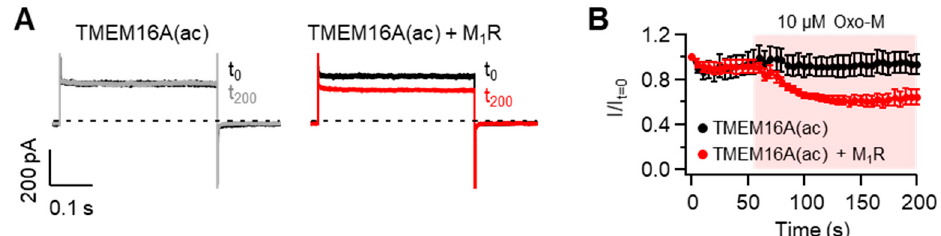
Figure 6. Modulation of TMEM16A(ac) channels by the M 1 muscarinic receptor (M 1 R). ( A ) Representative Cl − current traces of TMEM16A(ac) before and after application of the M 1 R agonist oxotremorine-M (Oxo-M). Whole-cell recordings were measured before ( t 0 , black) and 200 s after ( t 200 , gray and red) the application of 10 µ M Oxo-M in cells co-transfected without (left) and with (right) M 1 R. Cells were dialyzed with an intracellular solution including 10 mM EGTA and zero Ca 2+ , and the current was measured at +100 mV every 5 s. ( B ) Normalized mean current ± SEM. TMEM16A(ac), n = 5; TMEM16A(ac) + M 1 R, n = 5.